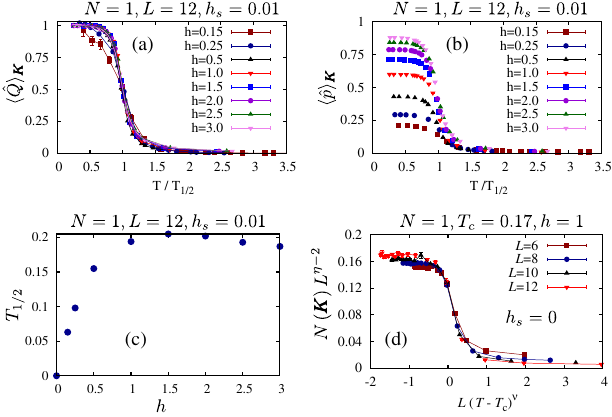
FIG. 4. (a) Staggered order parameter of Eq. (28) at finite symmetry-breaking field h s ¼ 0 . 01 . (b) Staggered order param- eter of Eq. (31) again at finite symmetry-breaking field h 0 . 01 . The temperature scale is normalized by T s ¼ in Eq. (30). (c) T 1 = 2 as a function of h . (d) Data collapse of the density-density correlation function defined in Eq. (32). This correlation function is related to the CDW order parameter via Eq. (34). A reasonable data collapse is obtained using the 2D Ising